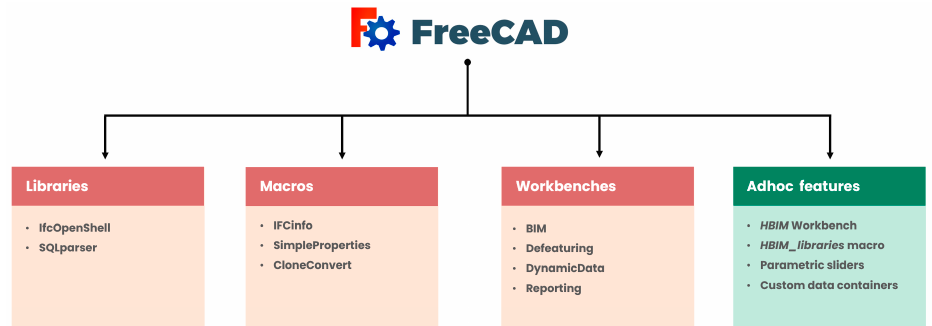
Figure 3. FreeCAD main implementations: from features developed by the community to specific features for